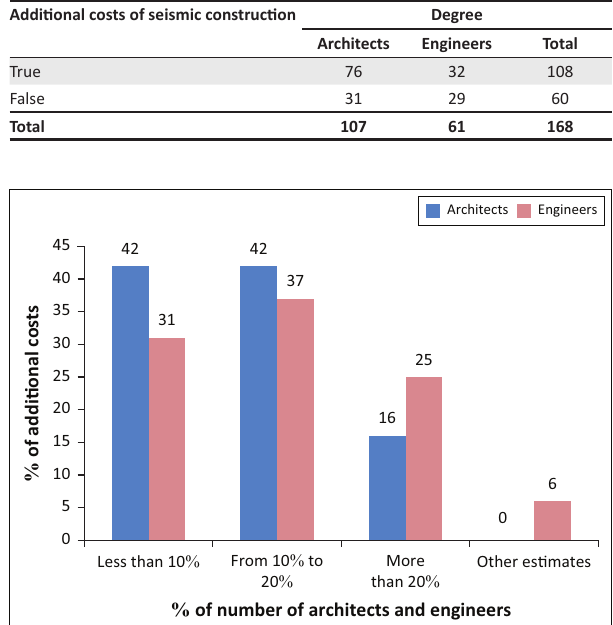
TABLE 15: Additional costs of seismic construction.